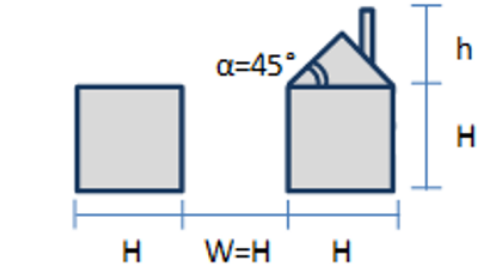
Fig. 4. Parameters to define the geometry of canyon and